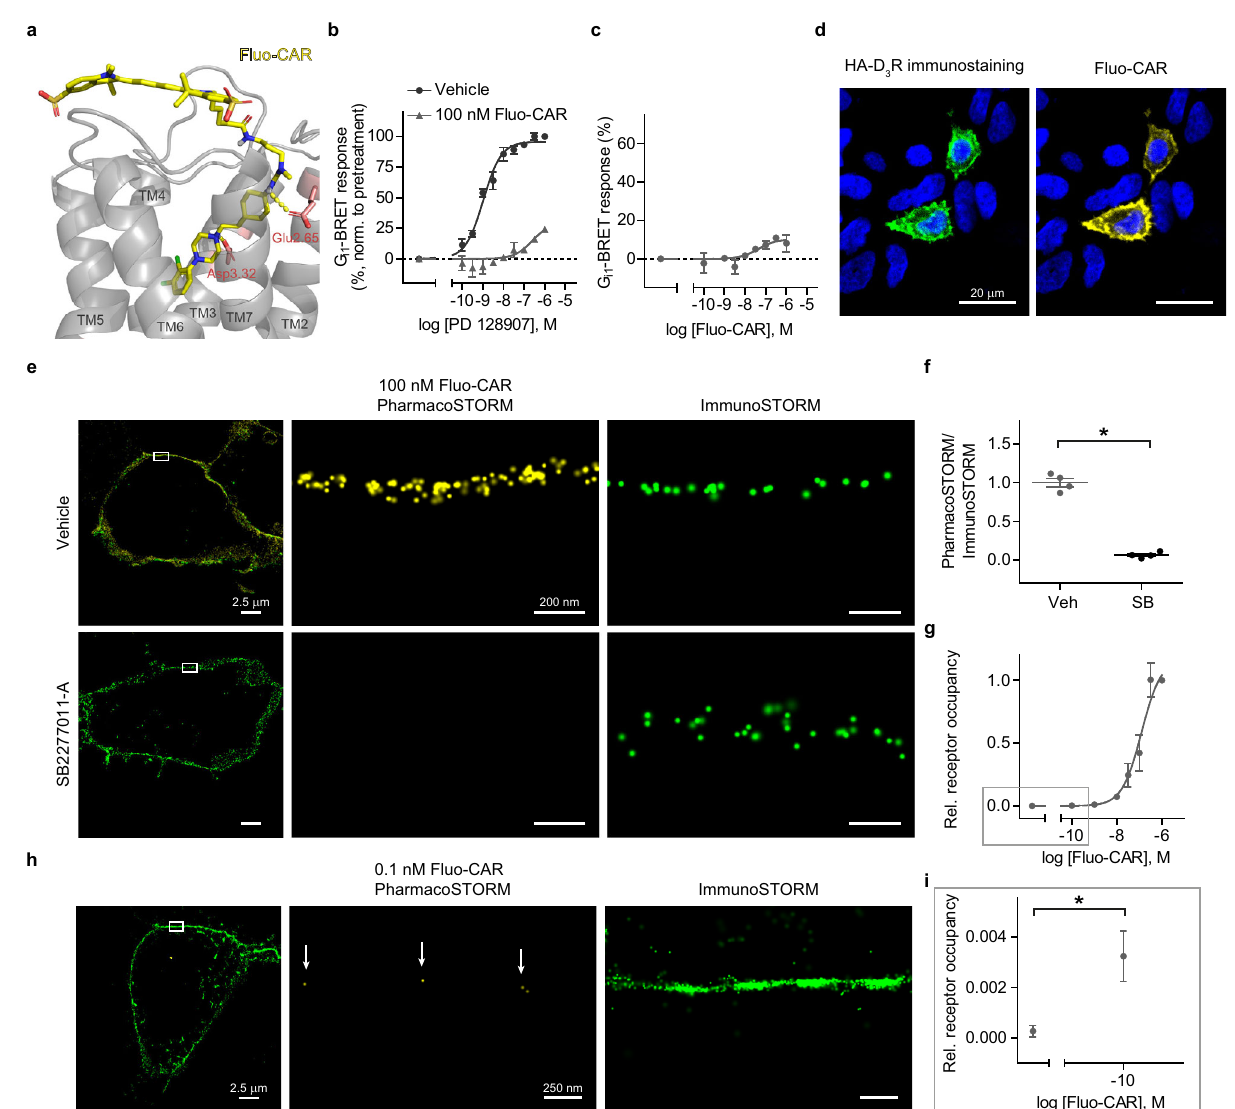
Fig. 2 Development and nanoscale pharmacological characterization of fl uo-cariprazine. a The docking pose of the fl uorescently tagged cariprazine (Fluo-CAR, yellow) in a D 3 R (gray) homology model (for details, see Supplementary Information). The hydrogen bonds between the key protein residues (Glu2.65, Asp3.32 in red) and the pharmacoprobe are represented as yellow dashed lines. b , c Functional effects of Fluo-CAR on D 3 R in BRET-based G i1 - activation assay. b Fluo-CAR antagonized the effect of the D 3 R selective agonist PD128907. Cells were incubated with Fluo-CAR or vehicle for 5 min before PD128907 application. Fluo-CAR pretreatment increased the EC 50 value of PD128907 from 1.047 nM to 256.1 nM ( n = 3). c Fluo-CAR alone acted as a weak partial agonist. Sigmoidal concentration-response curve was fi tted (EC 50 = 44.1 nm). BRET ratios are expressed as the percentage of the signal of 1 µ M PD128907 ( n = 3). d Representative confocal images of HA-D 3 R-expressing HEK 293 cells treated with Fluo-CAR (100 nM) following HA immunostaining. Fluo-CAR selectively binds those cells that express HA-D 3 R. e , f Competitive ligand-binding experiment assessed by quantitative dual direct STORM imaging. HA-D 3 R-expressing cells were incubated with either vehicle (Veh) or 10 µ M SB277011-A (SB), a selective D 3 R antagonist. The ratio of PharmacoSTORM and ImmunoSTORM localization points (LPs) was normalized to vehicle pretreatment. SB277011-A pretreatment markedly reduced the Fluo-CAR signal ( n = 4, two-tailed Mann – Whitney U test, P = 0.0286). g Saturation binding assay of Fluo-CAR treatment measured within the plasma membrane. Relative (rel.) receptor occupancy (the ratio of PharmacoSTORM and ImmunoSTORM LPs) was expressed as the percentage of the signal of 1 µ M Fluo-CAR, n values are (from left to the right) 4; 4; 3; 4; 3; 3; 3; 7. One-site sigmoidal binding curve was fi tted (half-maximal occupancy was at 123 nM). h , i Nanoscale visualization of Fluo-CAR binding sites in the sub-nanomolar concentration range. The representative image is shown in ( h ). White arrows point to sparsely bound individual Fluo-CAR molecules. i Higher magni fi cation of the lower concentration range from ( g ) is shown (two-tailed Mann – Whitney U test, P = 0.0294). Data are presented as mean ± SEM, n values indicate biologically independent experiments in all studies (Supplementary Fig. S8). Notably, 78% of fl uo-cariprazine protein binds a sole fl uo-cariprazine molecule, which is equipped molecules were detected as a single STORM localization point. with only one fl uorophore tag, an individual drug – receptor On the other hand, commercially available secondary antibodies interaction was often detected as a single STORM blinking event carry unknown number of fl uorophores. Accordingly, only 36% in the plasma membrane. Our systematic analysis revealed that of antibodies were represented as a single blinking event, and the this precise stoichiometry makes PharmacoSTORM probes rest were detected as “ localization point clusters ” with variable especially advantageous tools for true single-molecule localization